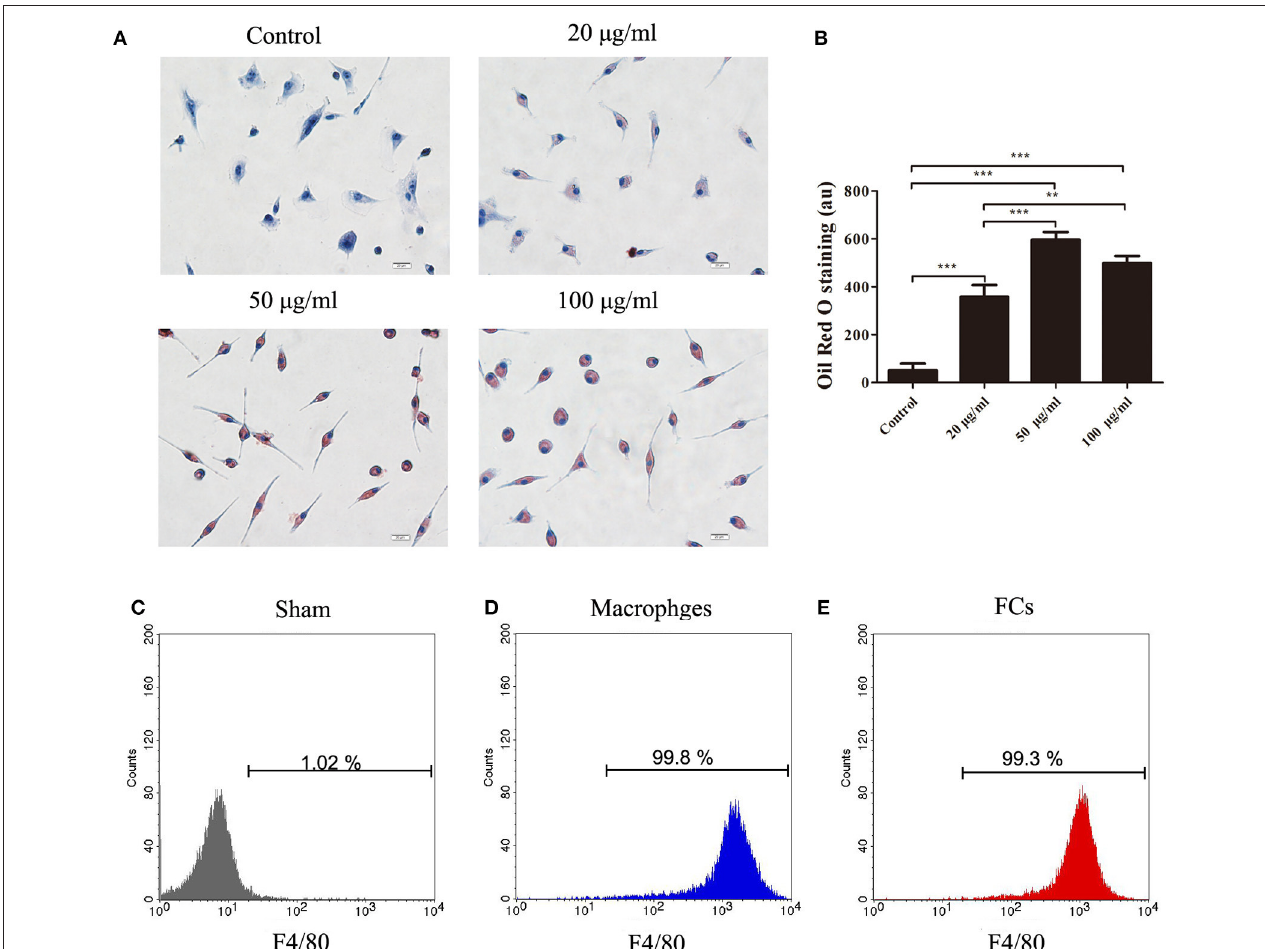
FIGURE 1 | The oxLDL uptake by peritoneal macrophages treated with or without oxLDL (20, 50 or 100 µ g/mL) for 24h. Internalized oxLDL were stained with Oil Red O. Six random fields per condition were observed with OLYMPUS BX53 microscope. (A) A representative image is shown for each condition. Scale bars, 20 µ m. (B) Quantification of intracellular oxLDL. The mean ± SEM of Oil Red O staining per condition is expressed in arbitrary units (au). Peritoneal macrophages or FCs were stained with APC anti-mouse F4/80. Flow cytometry histograms for macrophages (D) , and FCs (E) , respectively. Unlabeled macrophages were used as negative controls (C) . The experiment was performed in triplicate. ** p < 0.01; *** p <